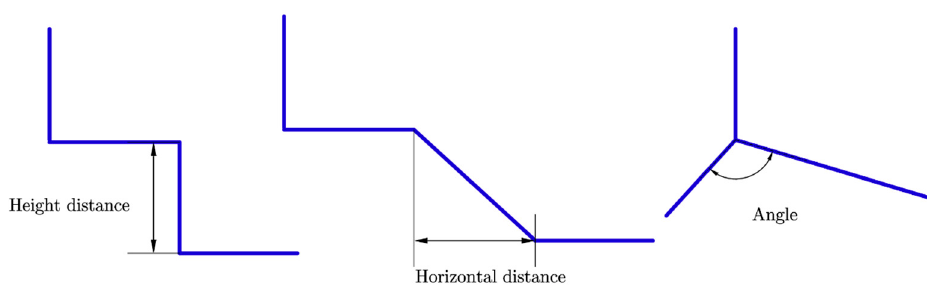
Figure 13. Impact parameters related to wellbore characteristics.